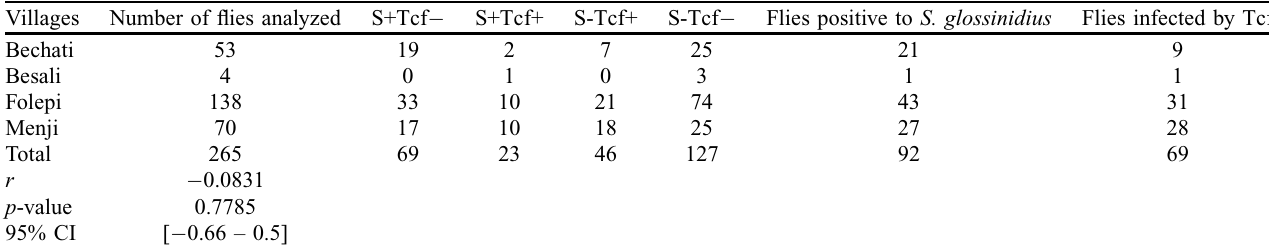
Table 4. Sodalis glossinidius and T. congolense co-infections according to villages.